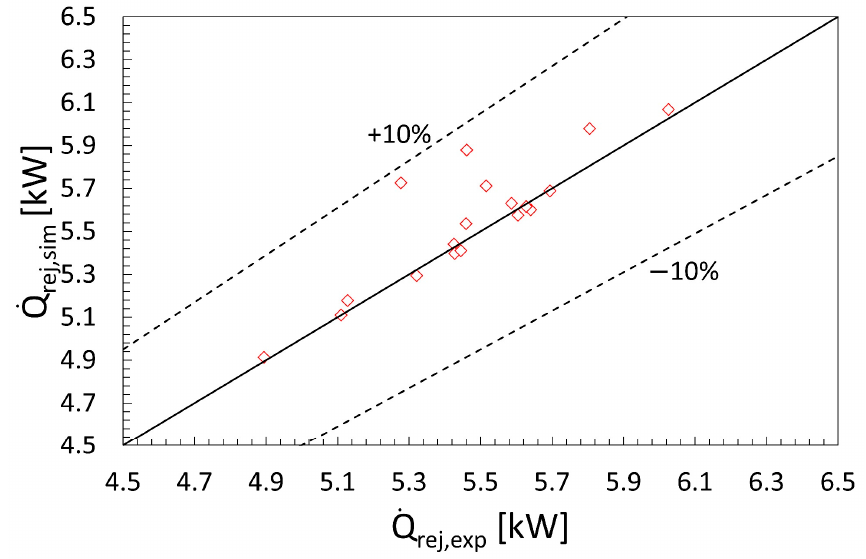
Figure 13. Comparison between the simulated heat rejected obtained by the numerical model and the corresponding experimental data for different working conditions of the gas cooler. The experimental distribution of the airflow was considered for the simulations.